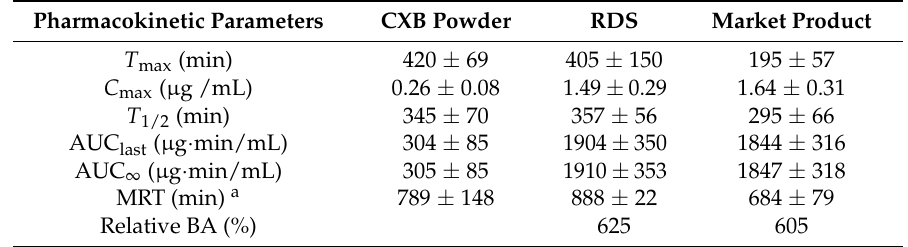
Figure 7. Plasma concentration profiles in the Sprague Dawley (SD) rats after oral administration of an equivalent dose of CXB (5 mg/kg), RDS, and marketed product (Celebrex ® ). Table 2. Pharmacokinetic parameters of celecoxib (CXB) following oral administration of CXB powder, RDS and a marketed product in rats ( n = 4, mean ± SD).